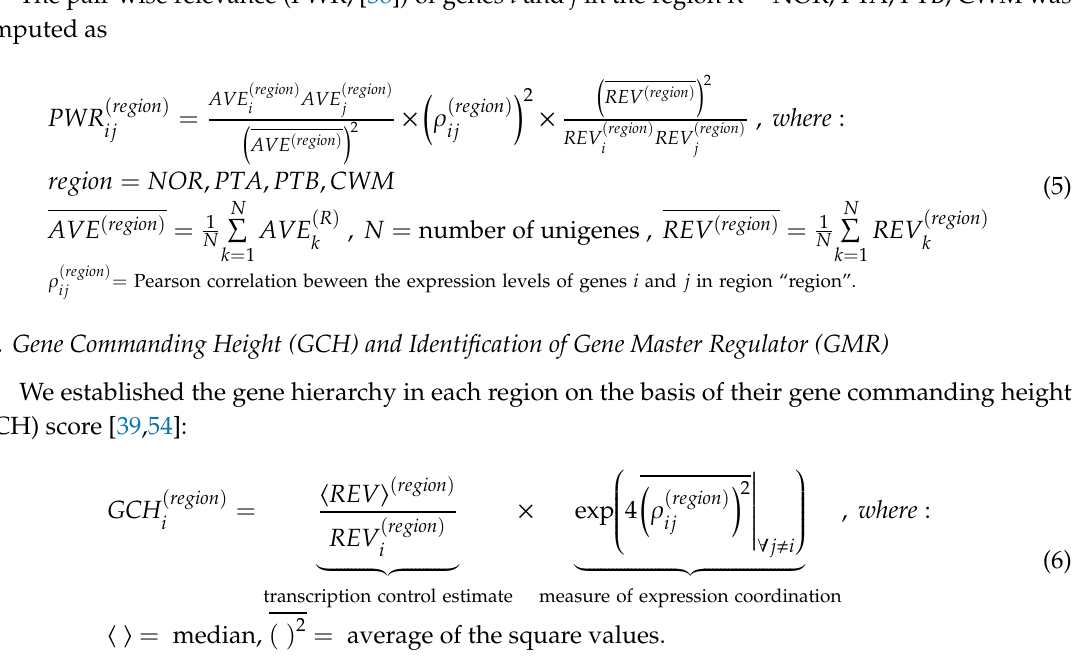
Figure S1: Regulation of the apoptosis pathway in (a) PTA, (b) PTB, and (c) CWM regions with respect to NOR, Figure S2: The PWR landscapes of mitochondrial genes in the four profiled